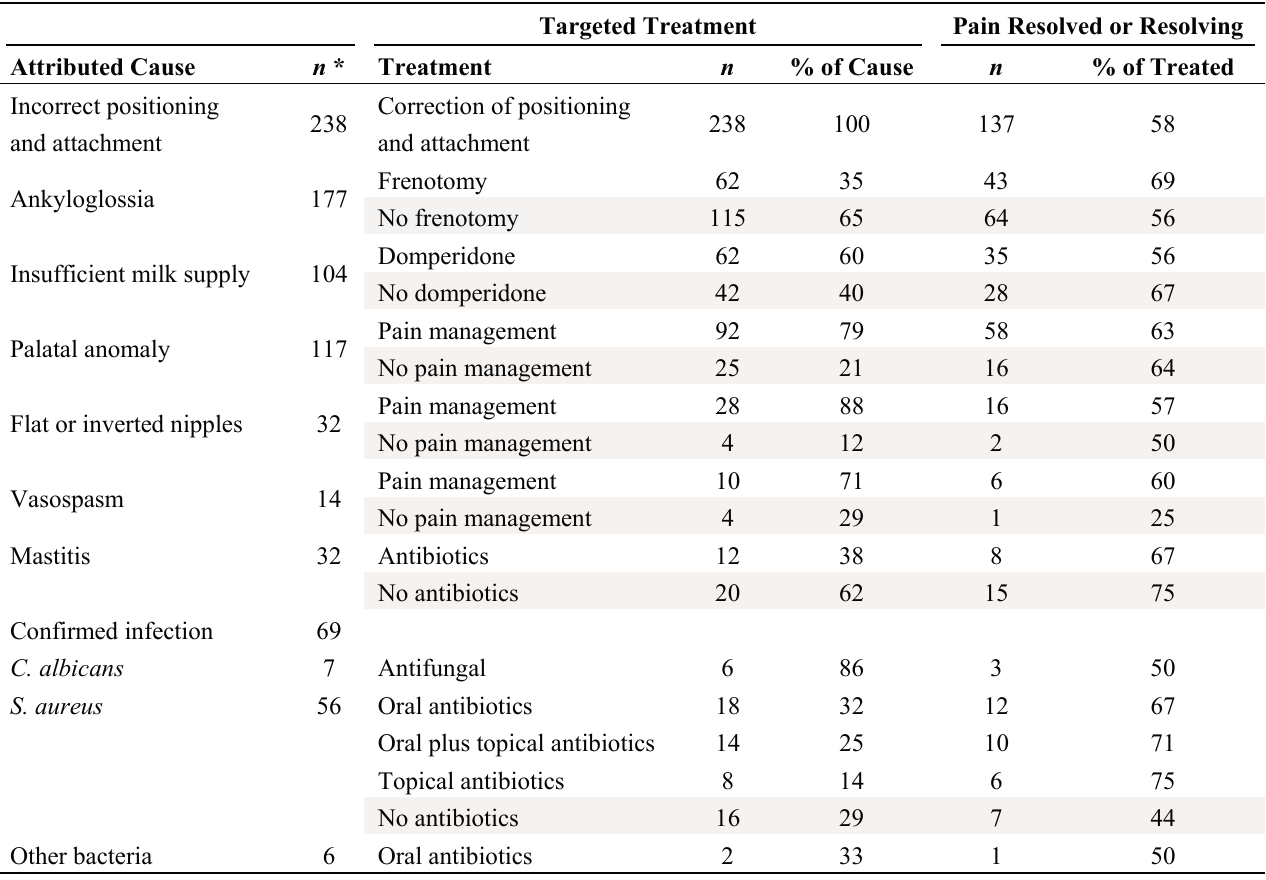
Table 4. Attributed causes, treatments and resolution of pain ( n = 264 cases). Targeted